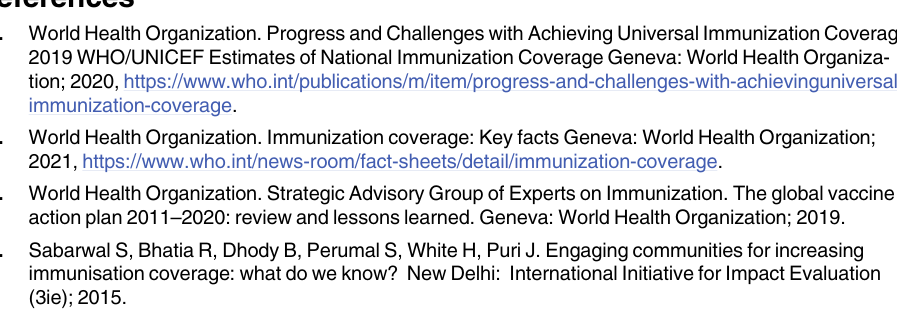
S1 Table. Formative evaluation coding structure. S2 Table. Description of interventions. S3 Table. Overview of formative evaluations included in the